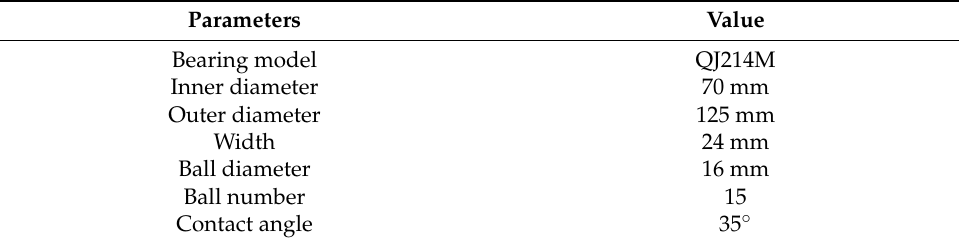
Figure 2. Test bearing and its installation. Table 2. Parameters of the test bearing.